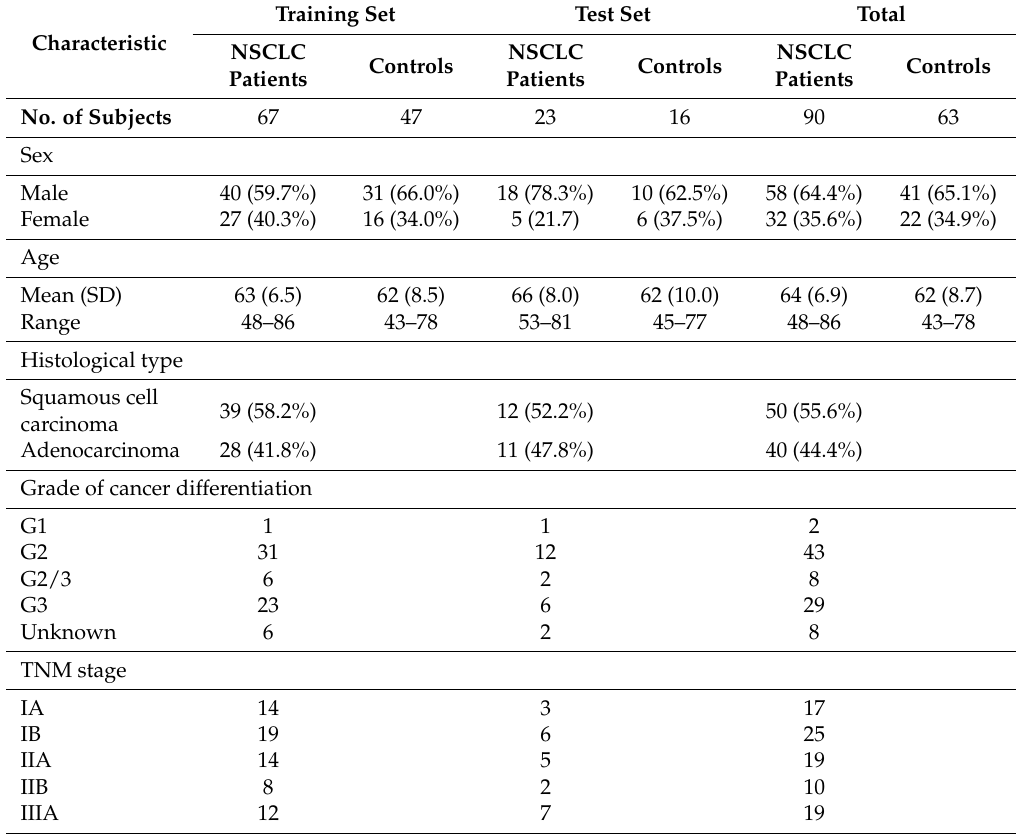
Table 1. Characteristics of non-small cell lung cancer (NSCLC) patients and control